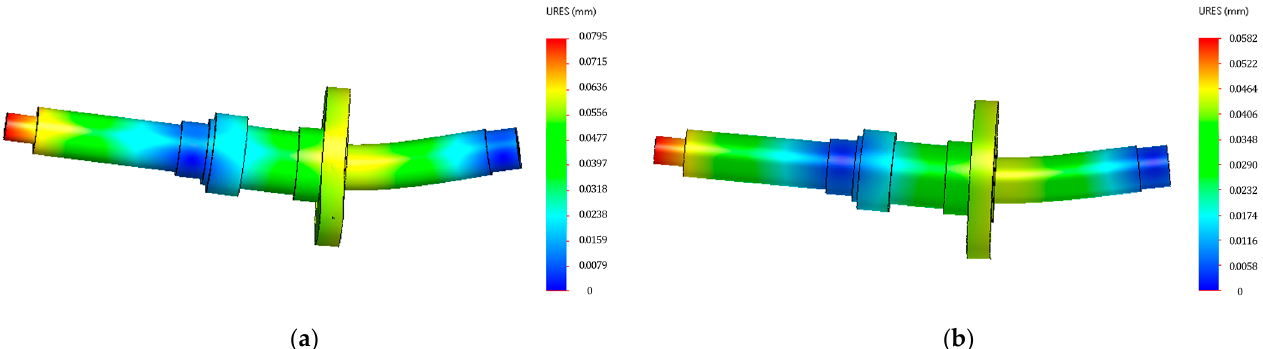
Figure 8. Fourth gear results: ( a ) boost; ( b ) recuperation.